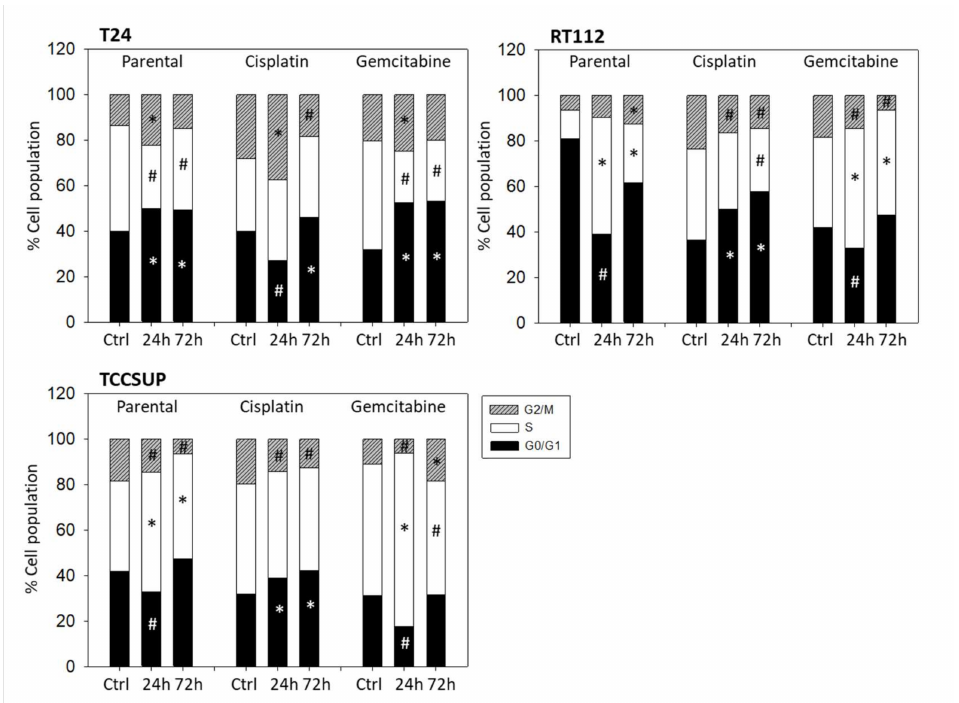
Figure 5. Cell cycle distribution in parental and resistant T24, RT112, and TCCSUP cells following OMWW (dilution 1:250) exposure for 24 and 72 h. Controls (Ctrl) remained untreated. One represen- tative of three separate experiments is shown ( n = 3). * indicates significant up-regulation, # indicates significant down-regulation, compared to the respective